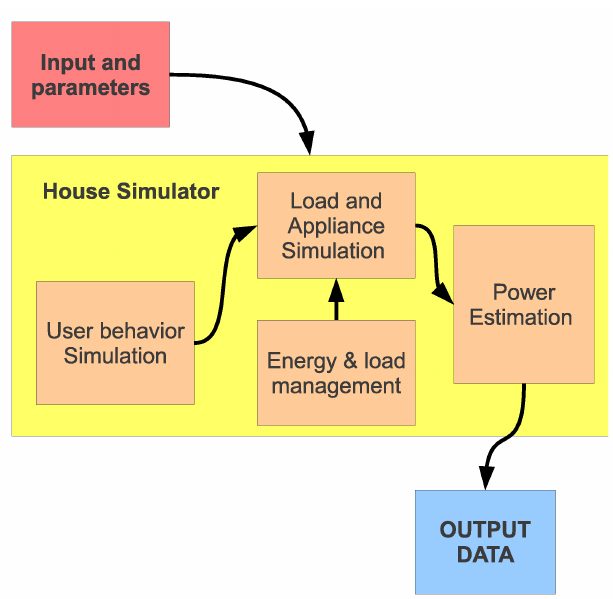
Figure 10. House simulator structure.